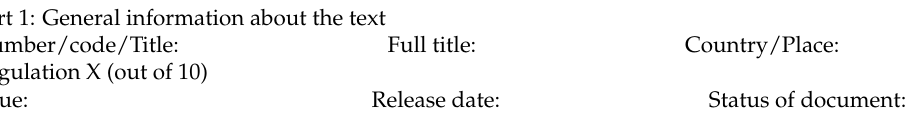
Table A1. Supertext template for critical frame